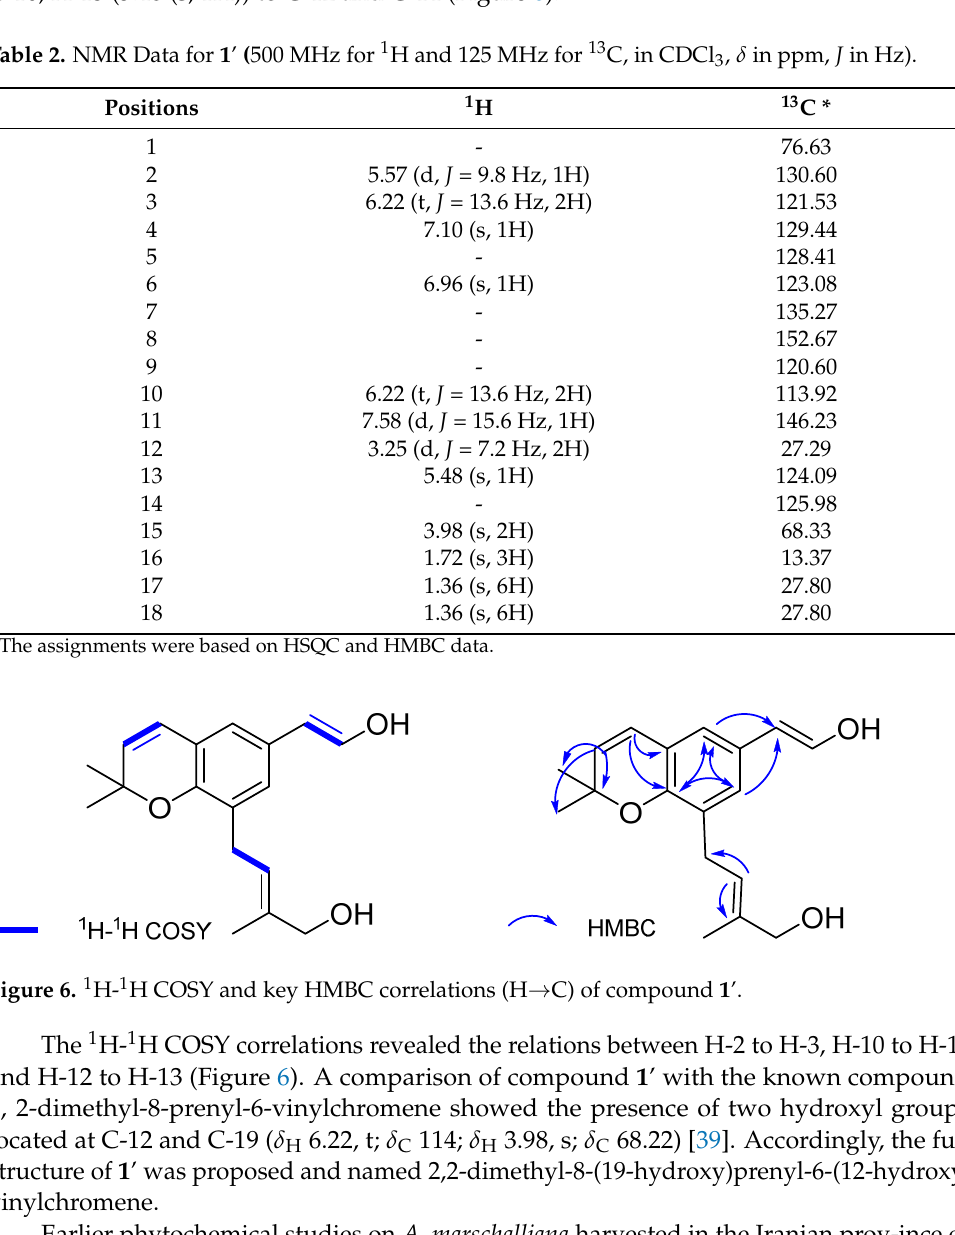
27.80 * The assignments were based on HSQC and HMBC data. Earlier phytochemical studies on A. marschalliana harvested in the Iranian prov-ince of East Azerbaijan led to the isolation and identification of a high concentration of oxy- genated sesquiterpenes [26,27], which is surprising due to fewer plants growing in Ka- zakhstan containing sesquiterpenoid compounds.